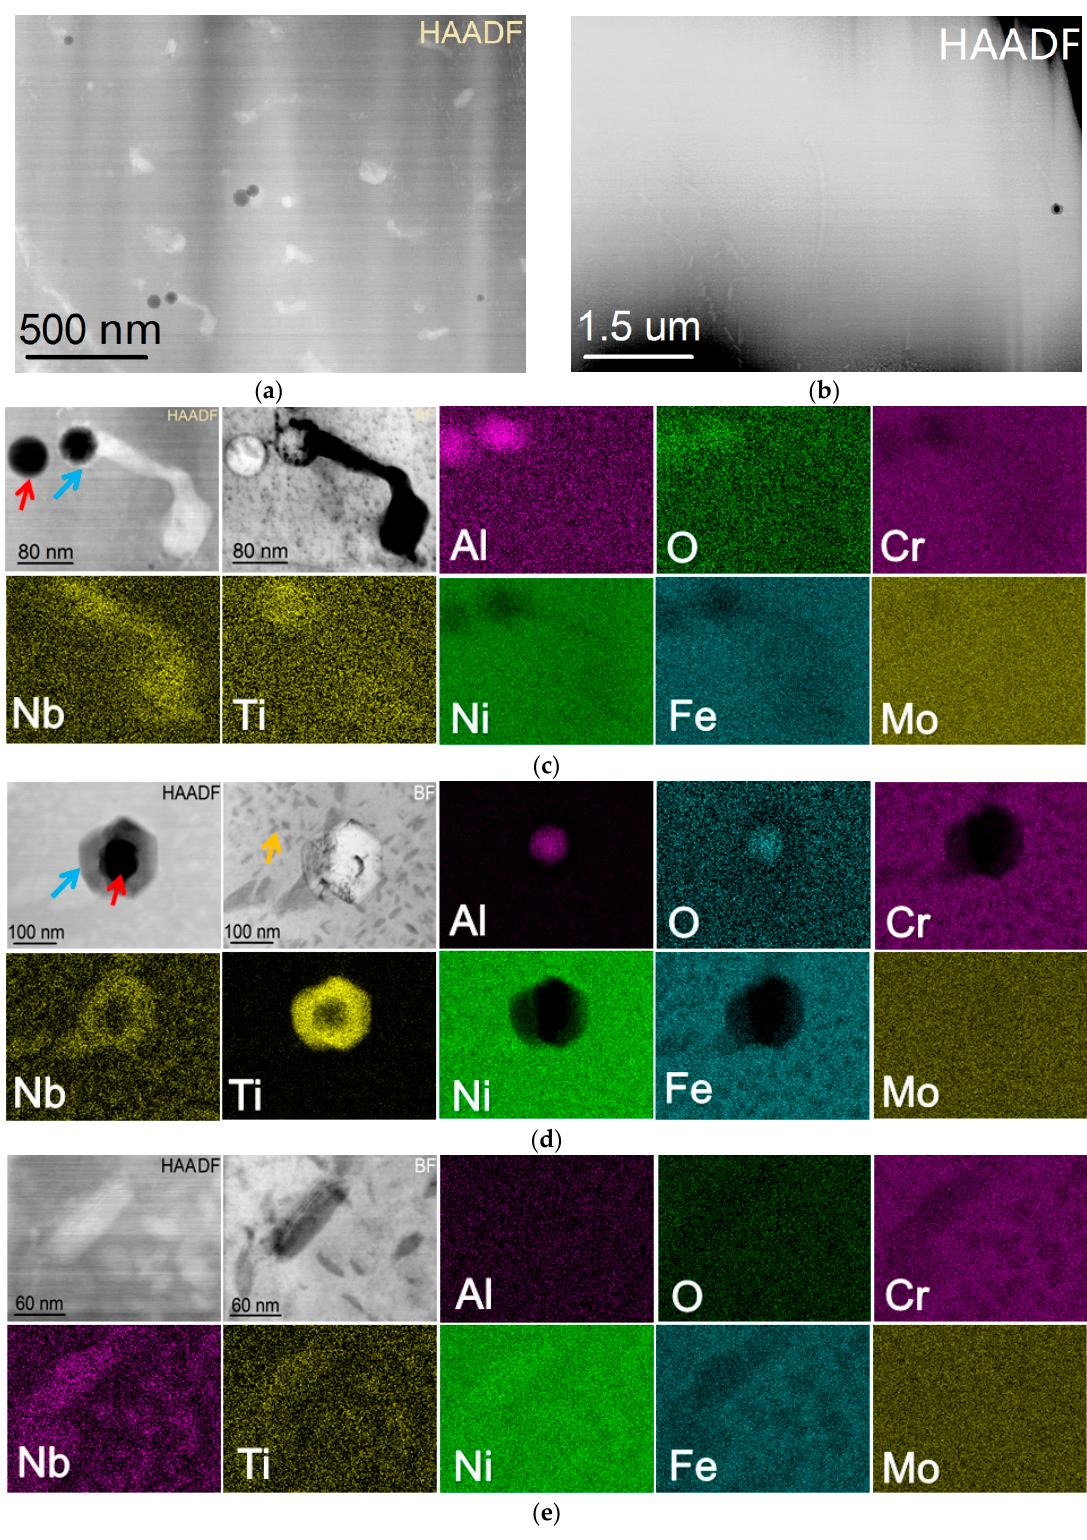
Figure 3. HAADF-STEM images of residues in the AM-fabricated IN718 samples and corresponding EDS elemental maps of Al, O, Cr, Nb, Ti, Ni, Fe, Mo, in which ( a , c ) belong to SLM-fabricated sample and ( b , d , e ) belong to EBM-processed sample.